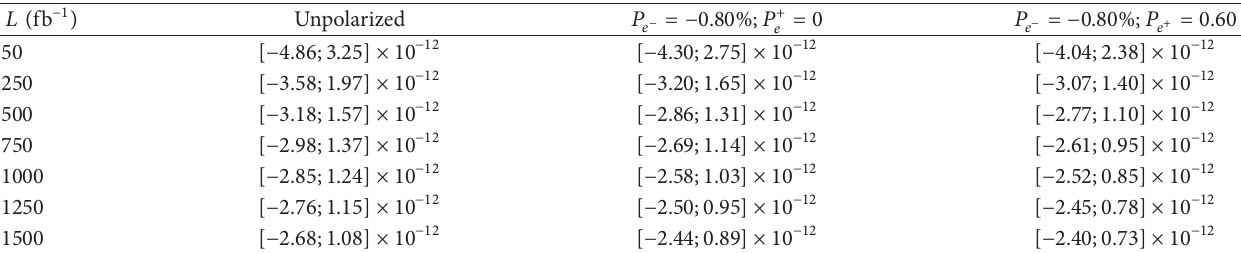
Table 7: Sensitivity of 𝑓 𝑇0 /Λ 4 at 95% CL for √𝑠 = 1.4 TeV in units of GeV −4